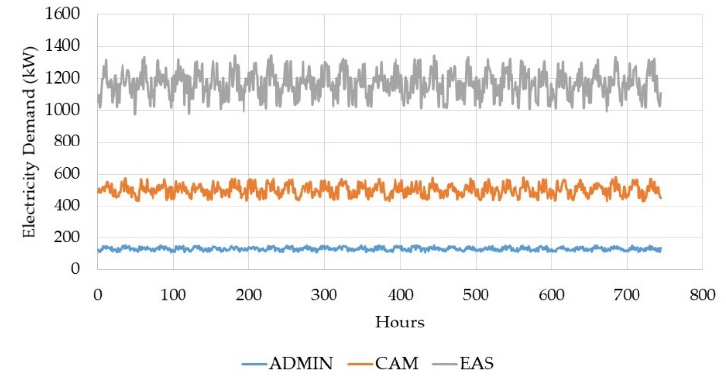
Figure 5. Hourly demand profiles of the three buildings during March 2019.